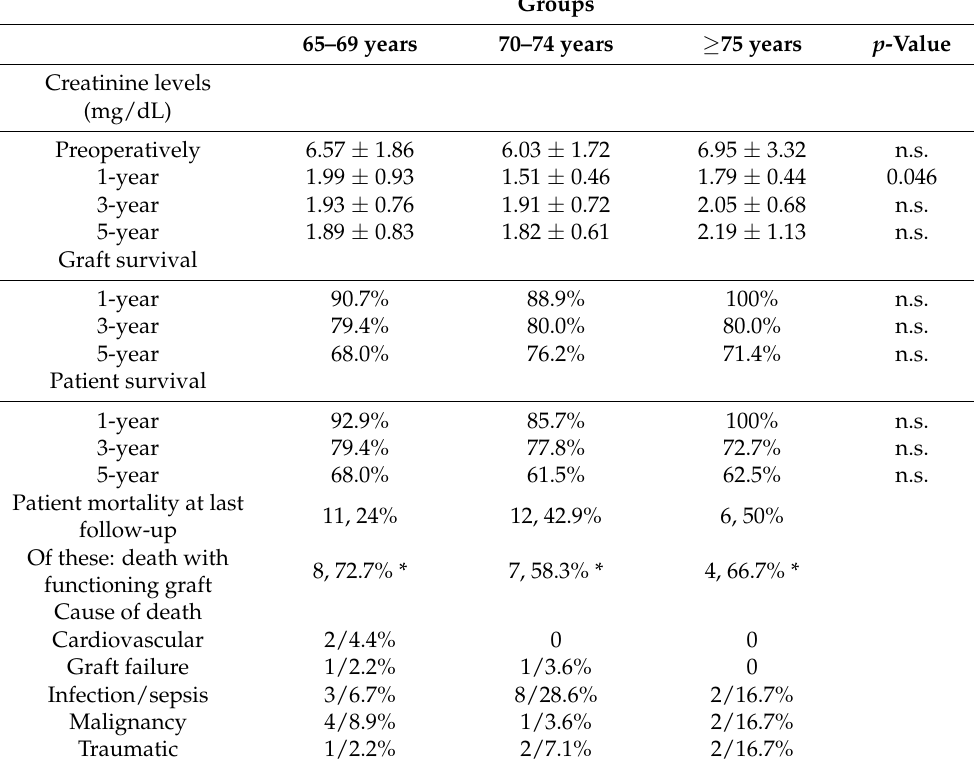
Table 4. Long-term outcomes.